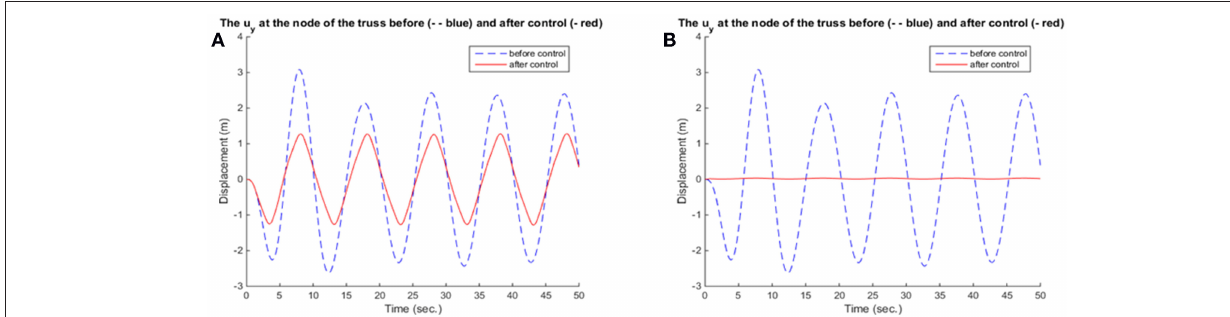
FIGURE 11 | Displacement of node 16 for (A) fuzzy controller and (B) neuro-fuzzy controller.